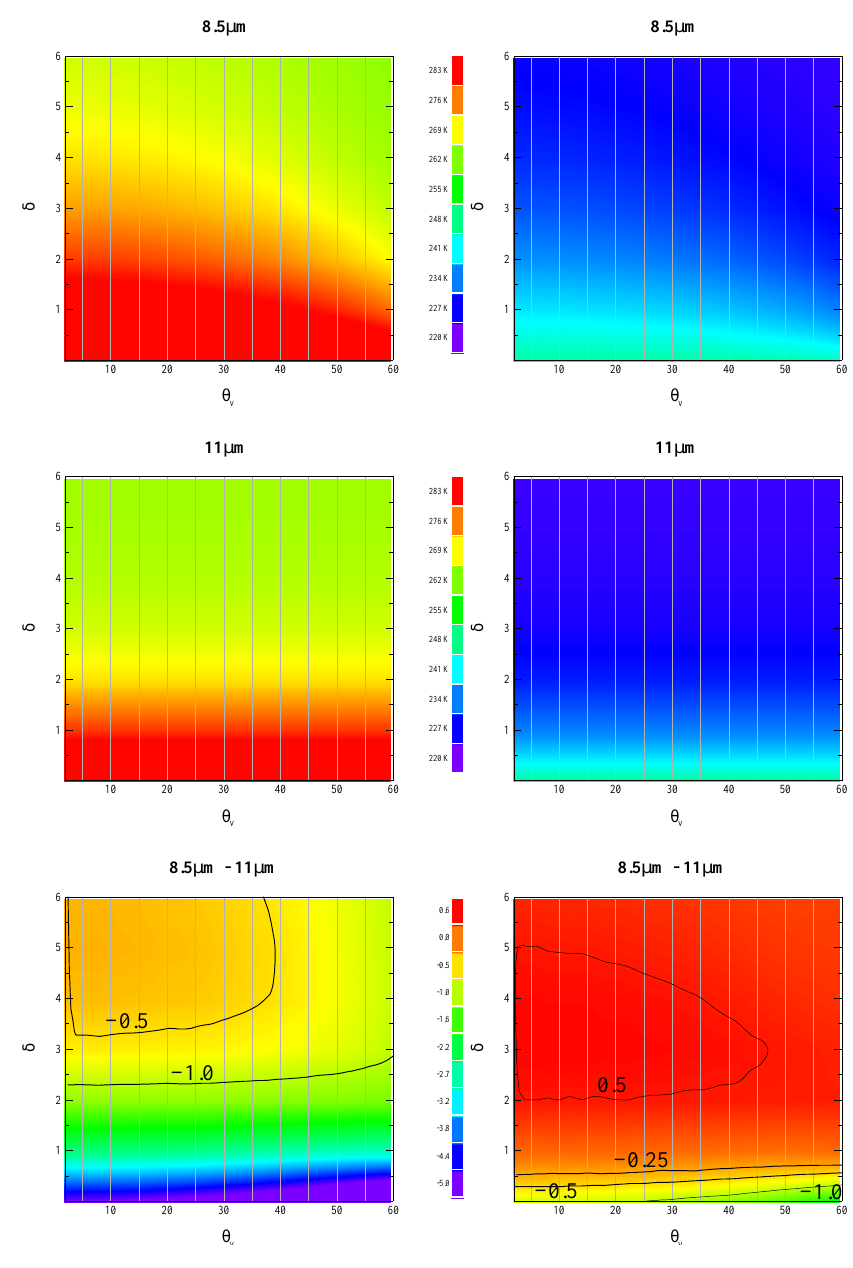
Fig. 9. Same as Fig. 8 but liquid cloud is located at 2km. identification of relatively thin clouds by these two tech-